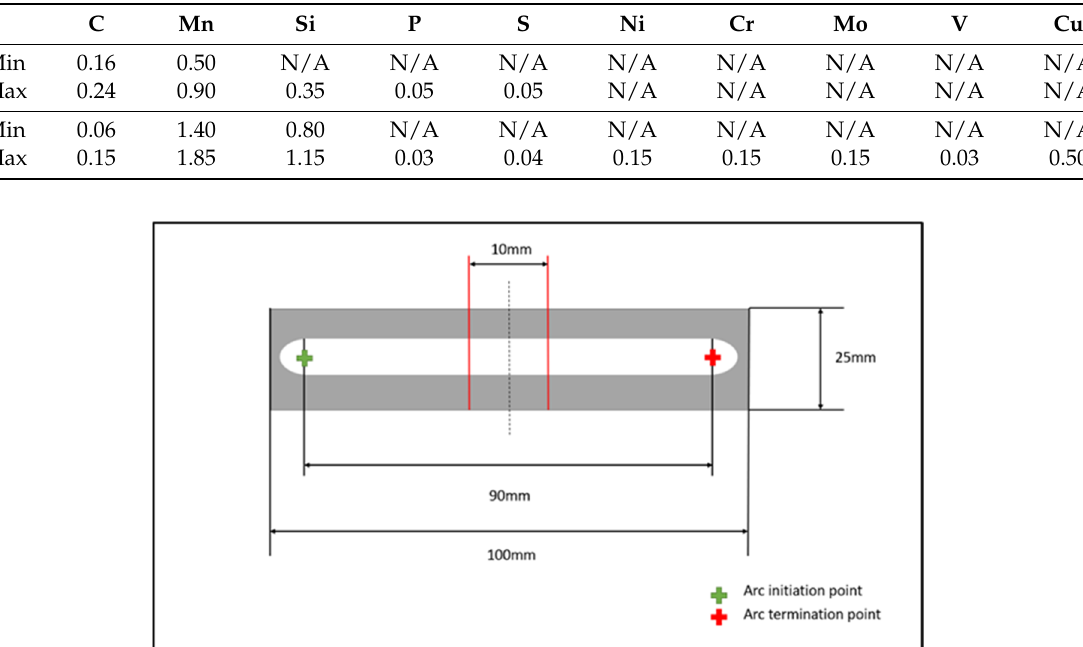
Figure 2. Diagram of specimen dimensions and cross-sectional cut area.